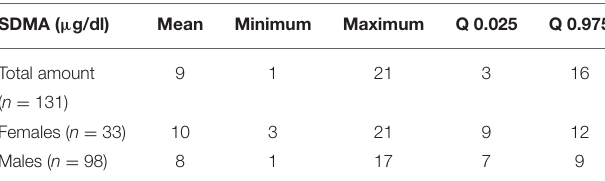
TABLE 1 | SDMA levels of female and male Hermann’s Tortoises ( n =